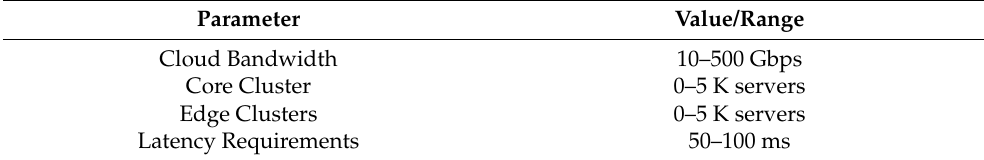
Table 3. System design parameters.